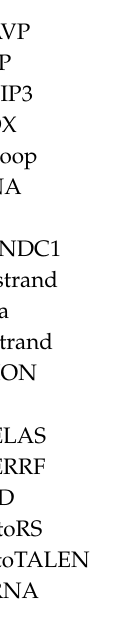
Table S1: MtDNA mutations reported in common mitochondrial DNA